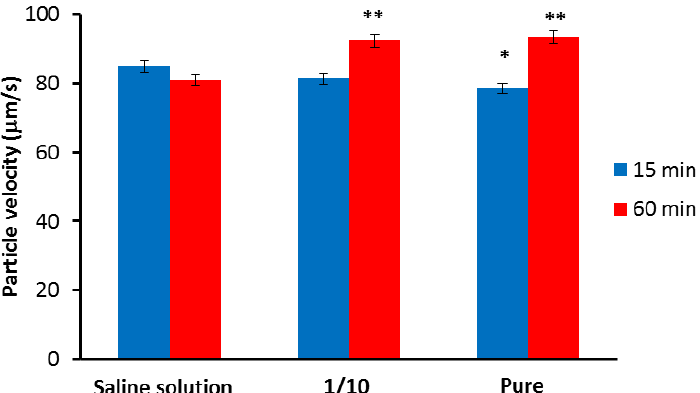
Figure 9. Mucociliary clearance of a nasal epithelium tissue model, after exposure to a pure saline solution used as a control, or a diluted (1/10 dilution ratio) and a concentrated (pure) Rhinosectan ® sample. Two exposure times were tested: 15 or 60 min. The clearance was quantified as the velocity of movement of polystyrene microparticles with a size of 30 μ m. Asterisks indicate p values (Student T test): ** p < 0.01, * p < 0.05 comparing to saline solutions. (Figure adapted from Reference [116], with permission of BMC, editor of the journal Allergy, Asthma and Clinical Immunology. )